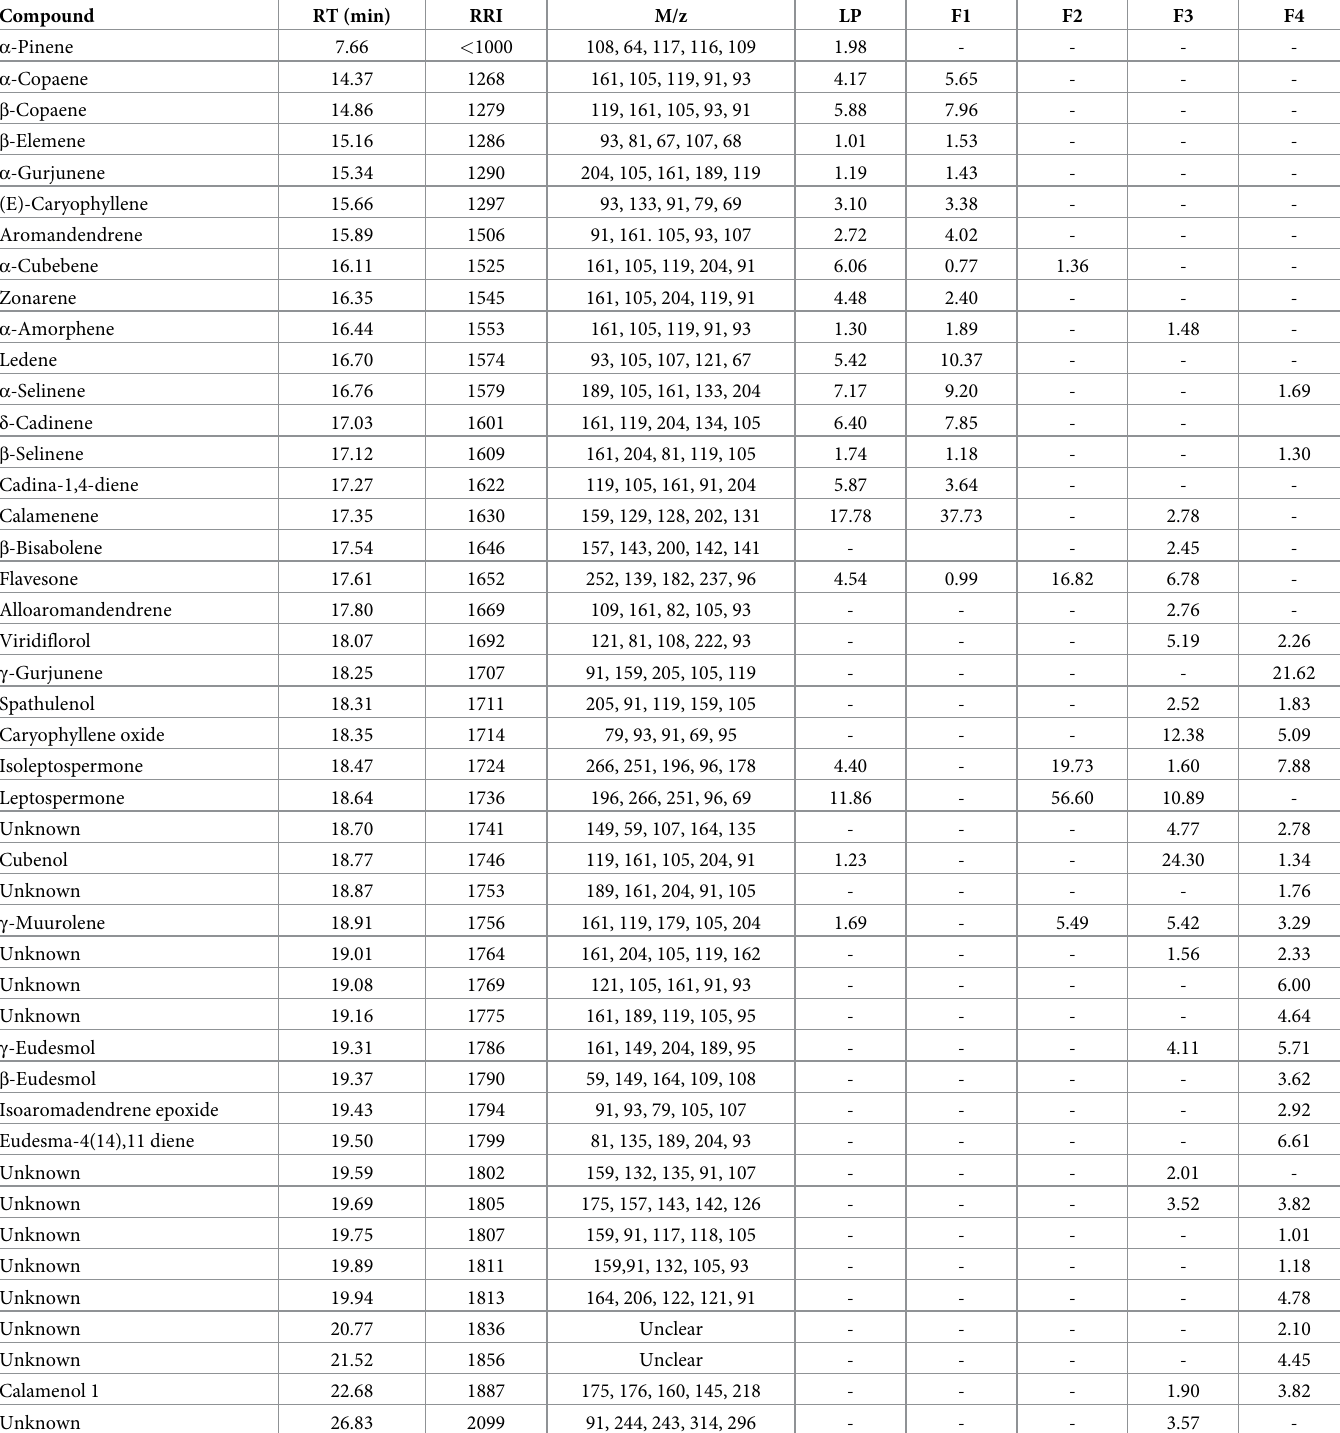
Table 1. Chemical composition of L . scoparium essential oil and its fractions. LP, L . scoparium essential oil, F1-F4, fractions 1–4. Also included are retention time from the GC-FID with relative retention index (RRI), and the major fragmentations ions observed by GC-MS listed in order of relative abundance. Dash (-) indicates that the compound was not